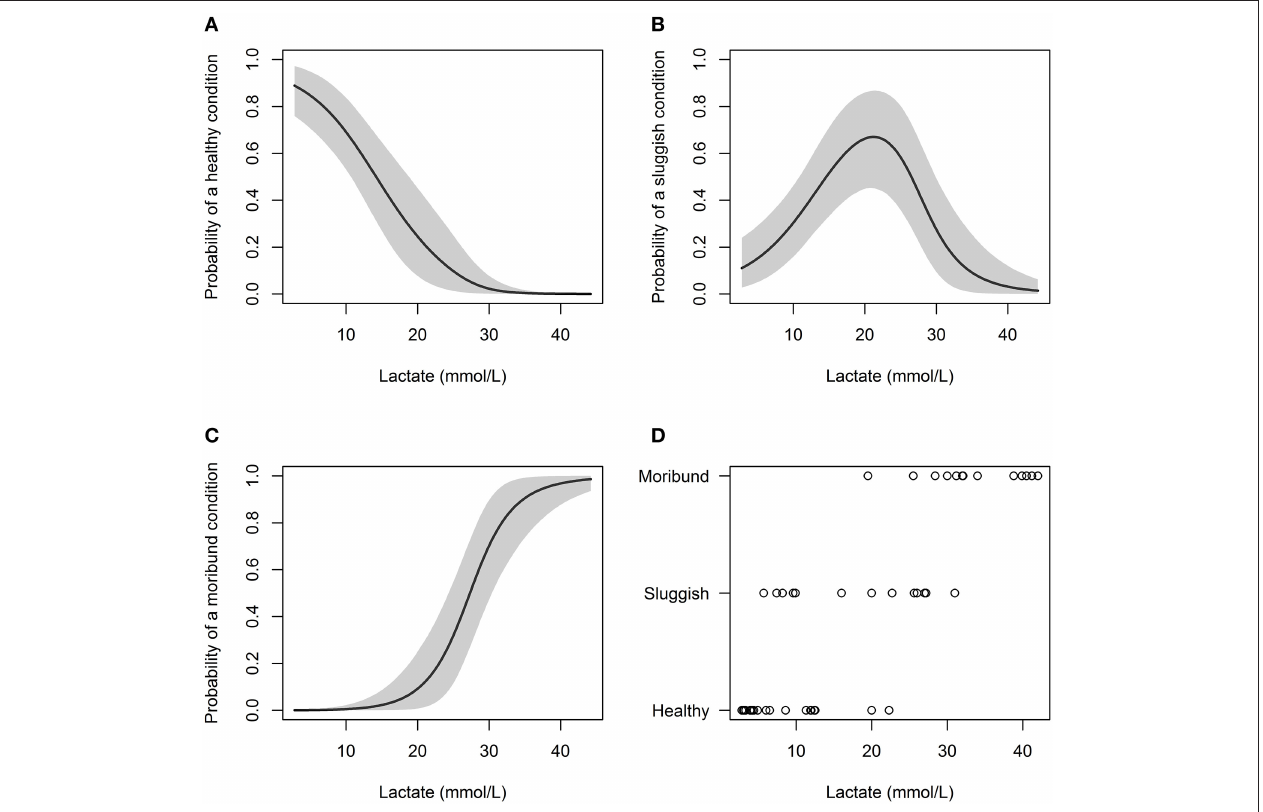
FIGURE 2 | Probability of C. brachyurus being boated in a certain condition (A – “healthy,” B – “sluggish,” C – “moribund or dead”) given a plasma lactate concentration. Gray shading in (A–C) represents 95% credibility intervals. (D) Plots the raw data vs. lactate concentration, sorted by category (“healthy,” “sluggish,” “moribund or dead”). The mean plasma lactate concentrations for captured sharks in “healthy,” “sluggish,” and “moribund or dead” conditions were 7.7, 18.0, and 33.5mmol/L,